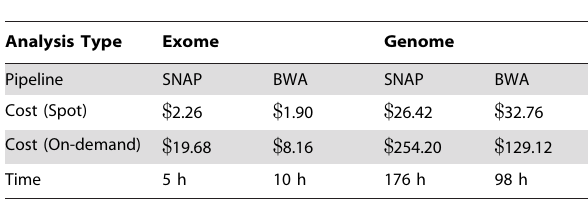
for BWA (red) and SNAP (blue). These figures are estimates only and results may vary. The merged step includes initial aligned